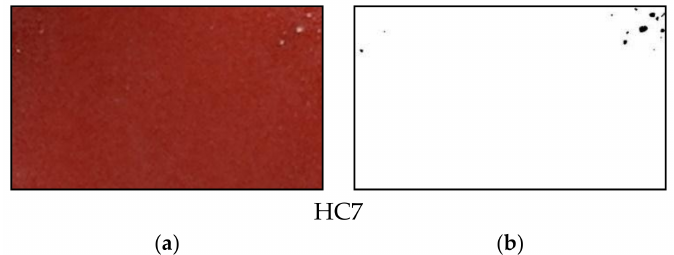
Figure 5. Processing results of HC1–HC7 level images. ( a ) Original image; and, ( b ) processing result